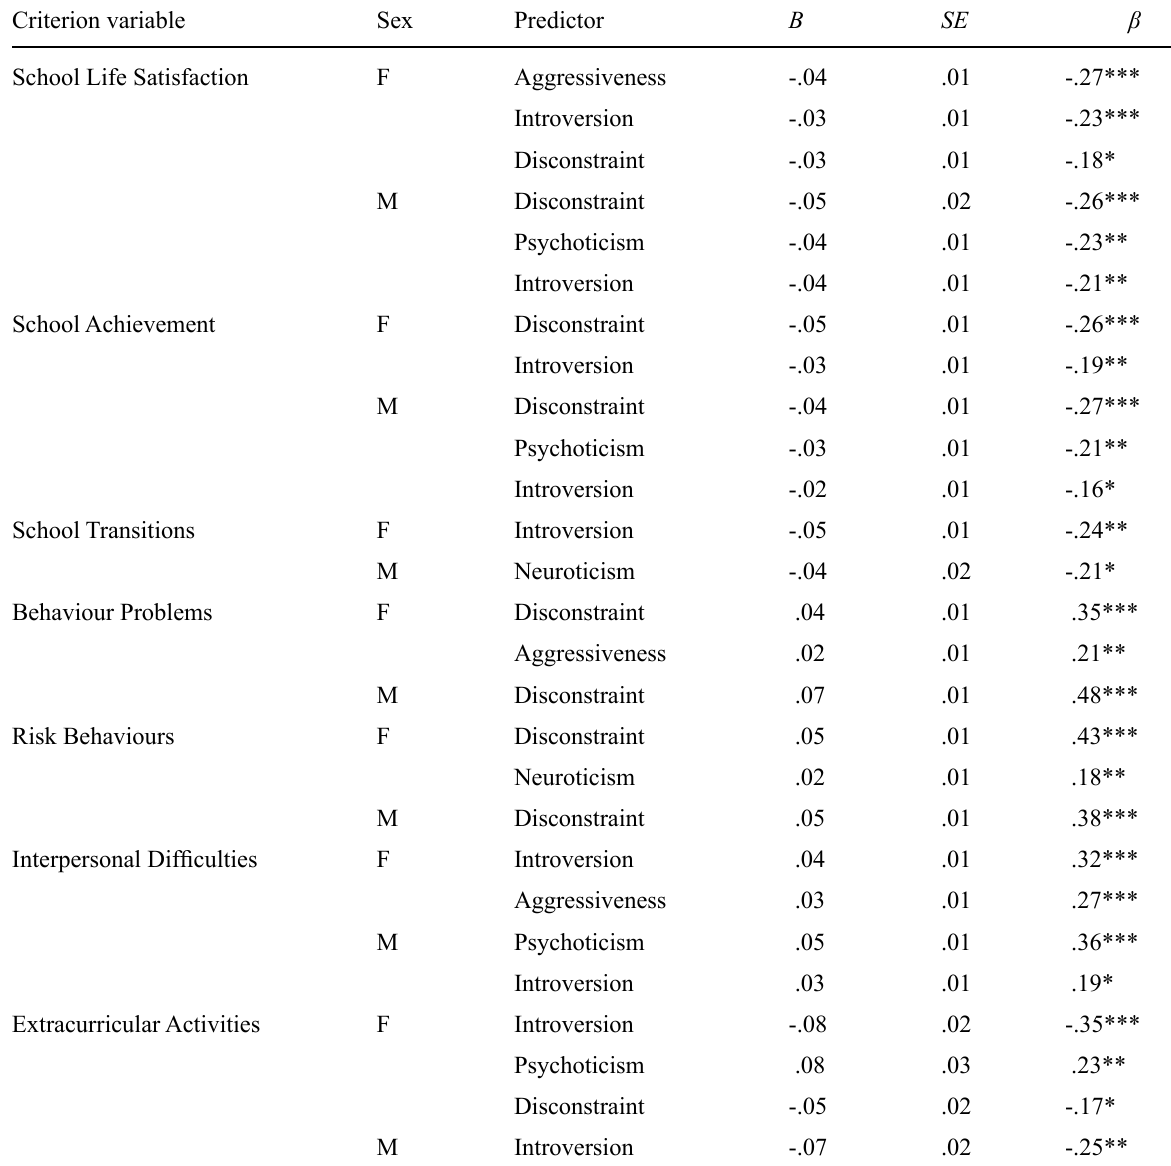
Regression Coef fi cients of School Path Variables on PSY-5 Personality Dimensions, for Each Sex Criterion